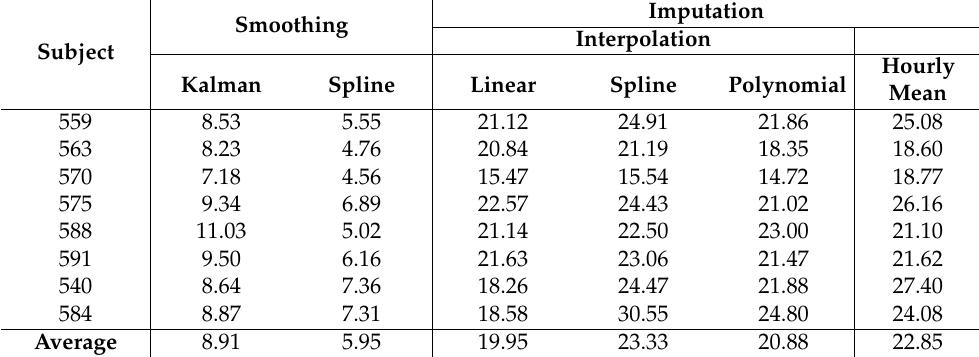
Table 8. Average RMSE for predicting glucose level using bivariate (CGM and meal) 1D-CNN after